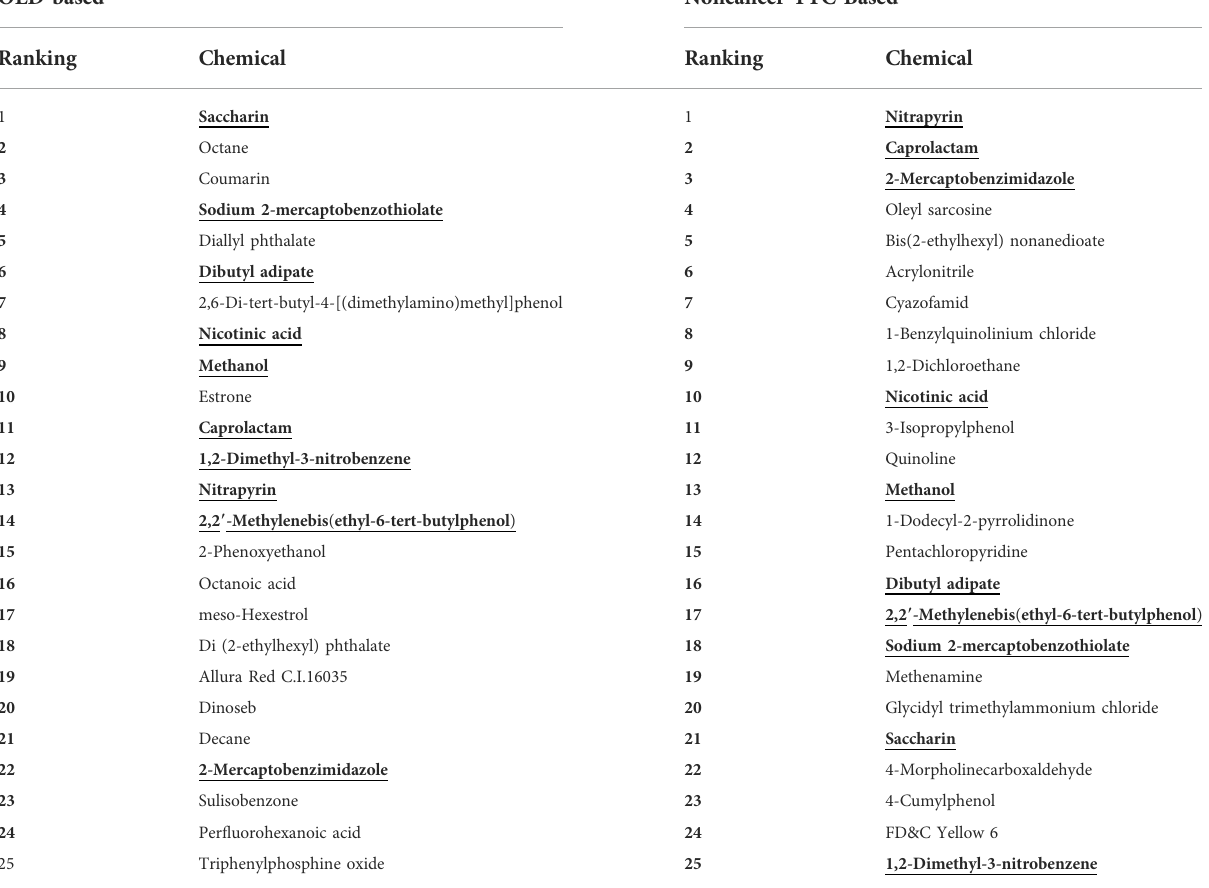
TABLE 2 Summary of top 25 chemicals for the small dataset ranked by increasing value of estimated margins of exposure (MoEs). OEDs were divided byExpoCastSEEMexposureestimatestoobtainOED-basedMoEs.NoncancerTTCsweredividedbyExpoCastSEEMexposureestimatestoobtain TTC-based MoEs. Chemicals in both lists have been bolded and